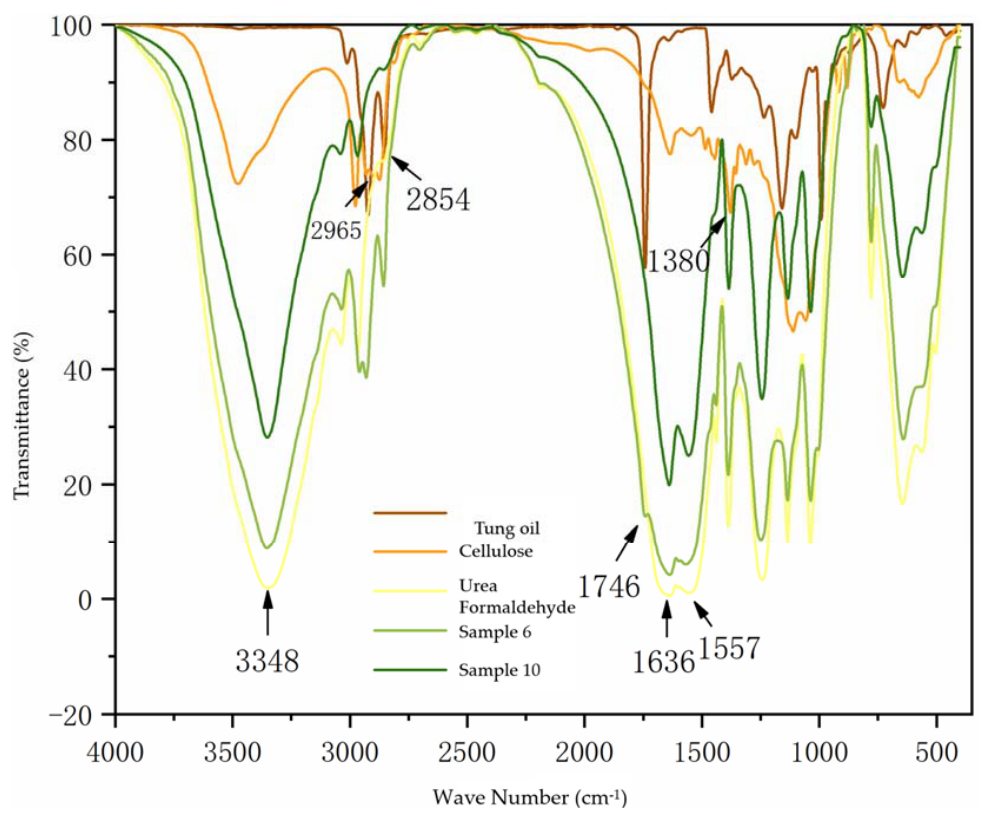
Figure 2. IR spectra of microcapsules, core material, and wall material.